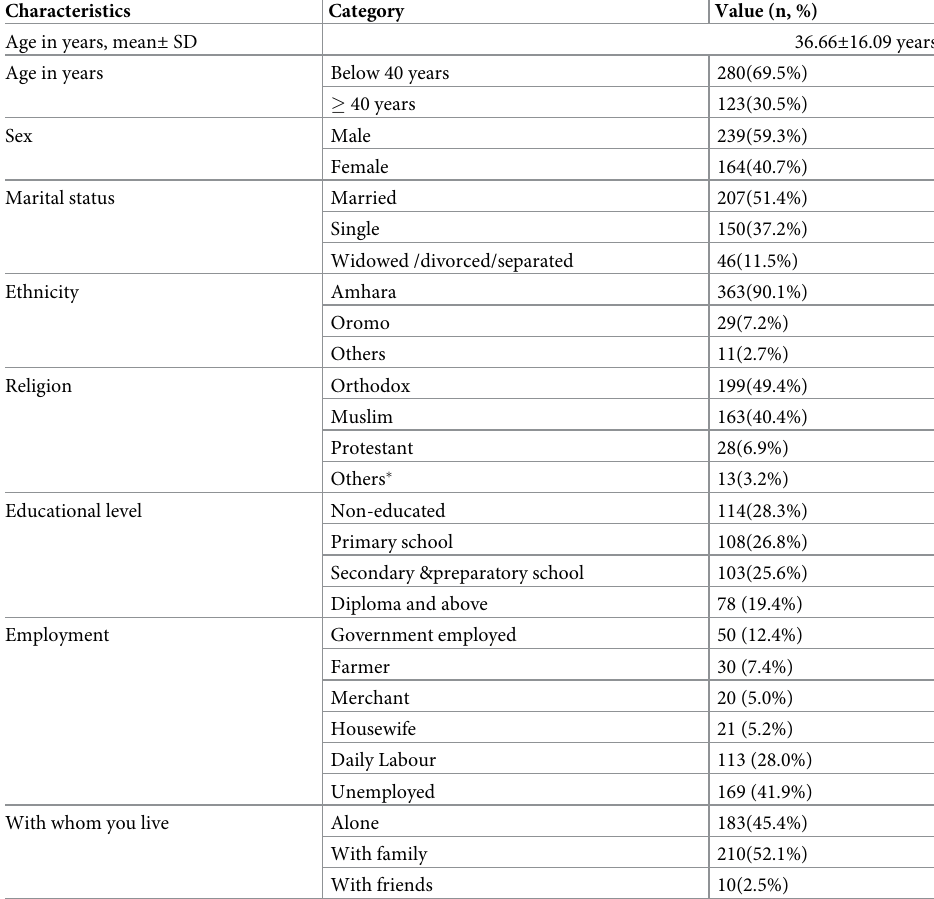
Table 1. Socio-demographic characteristics of individuals living with a disability.